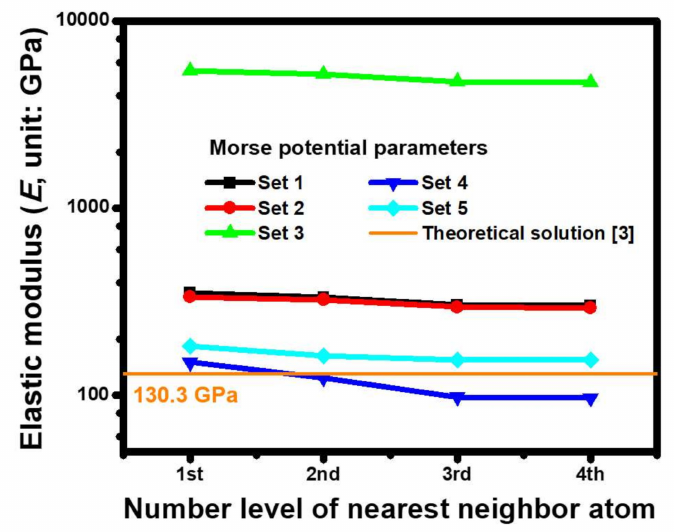
Figure 4. A comparison of E for a Cu(110) crystal cube with a length of 30 a ( a = 3.61 Å), estimated by means of the Morse parameters of five sets presented in this study, as various cut-o ff levels of the pairwise interaction are taken into